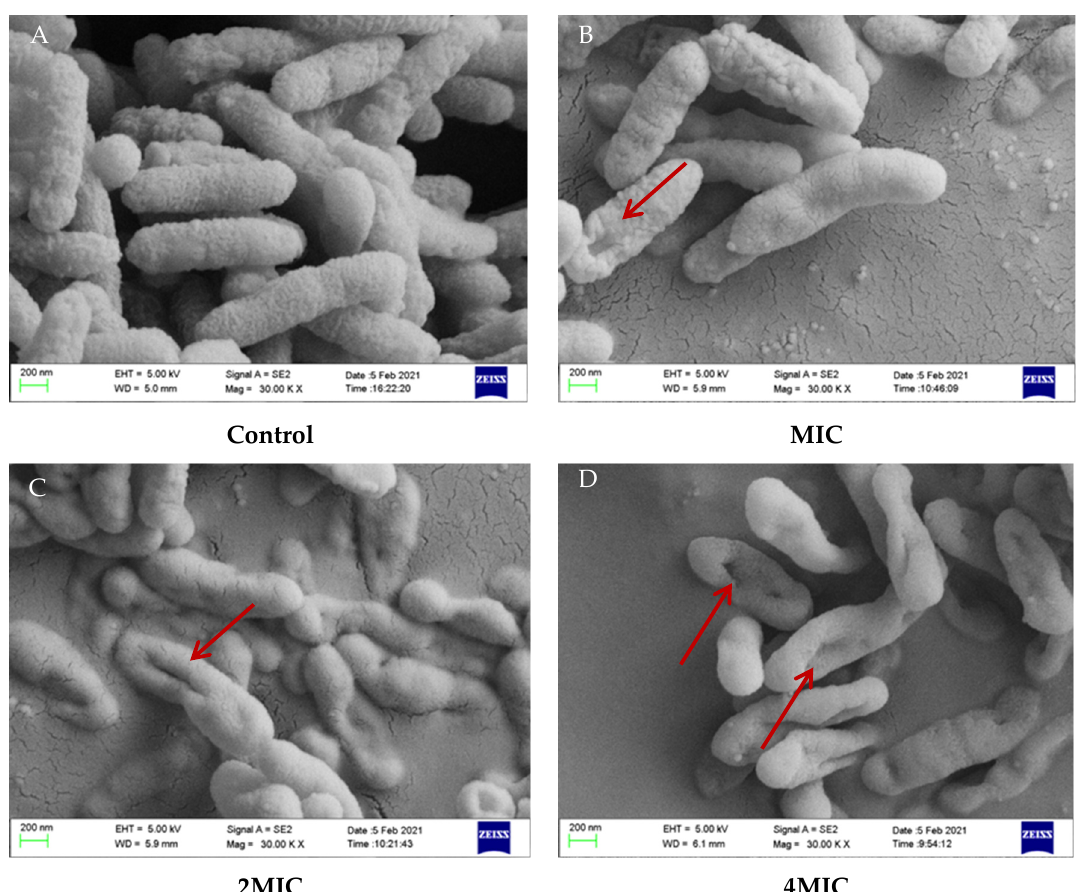
Figure 5. SEM image of Xoo after treatments with different concentrations of 4-allylbenzene-1,2-diol ( A ) control; ( B ) MIC; ( C ) 2 MIC; ( D ) 4 MIC.